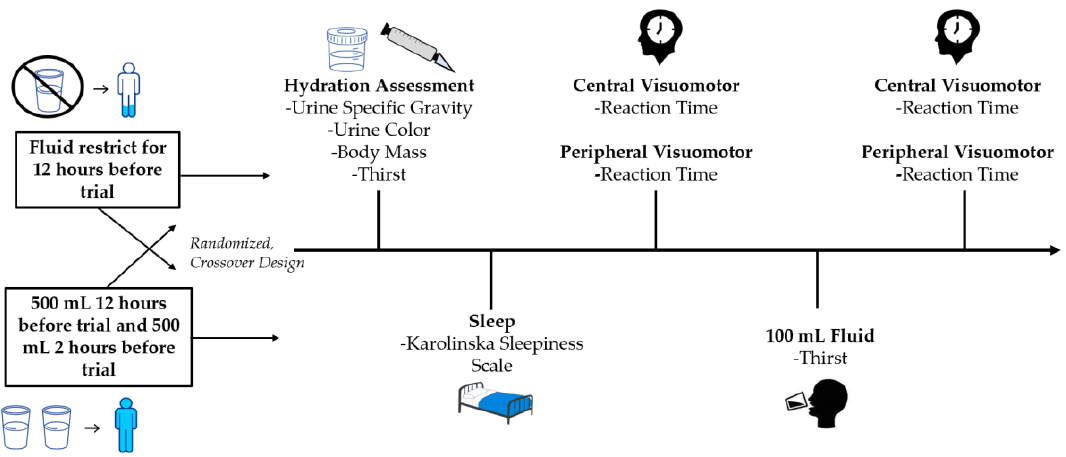
Figure 1. Study timeline.